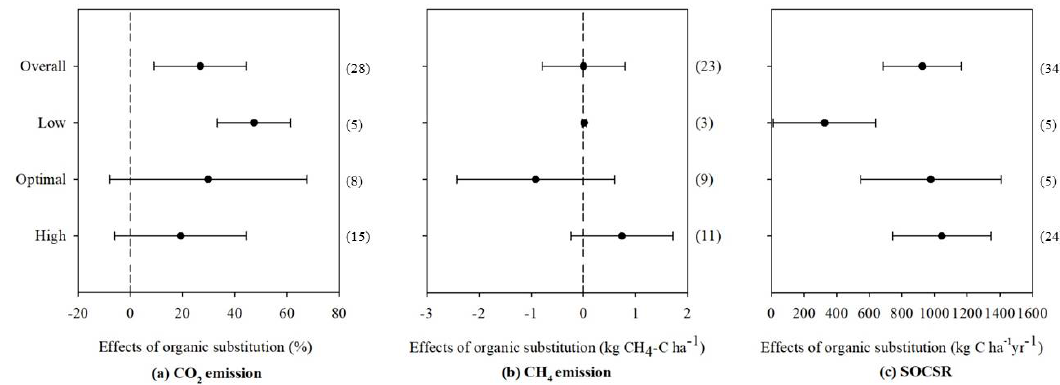
Figure 3. Effects of organic fertilizer substitution on CO 2 emissions ( a ), CH 4 emissions ( b ), and SOCSR ( c ) under three fertilization rates (see main text for definitions of the low, optimal, and high fertilization rates). SOCSR indicates soil organic carbon sequestration rate. Error bars represent 95% confidence intervals. Numbers in parentheses indicate the numbers of observations.